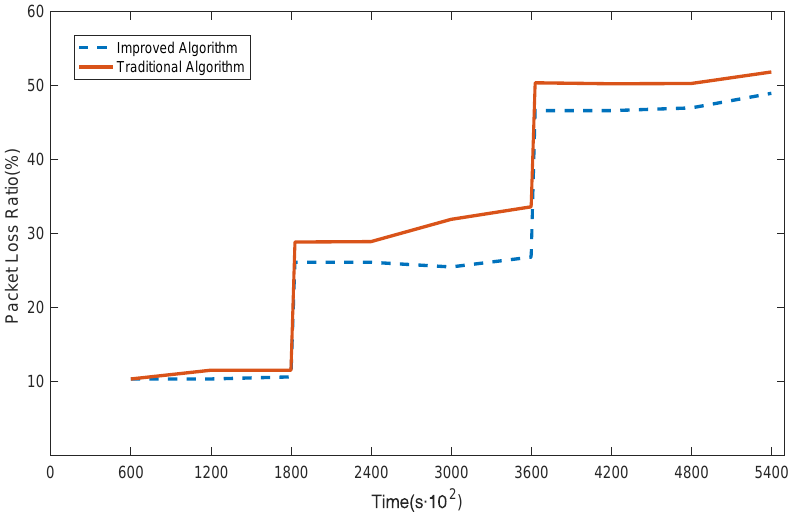
Figure 11. Trend of the packet loss ratio in two algorithms during the dynamic change in the number of malicious